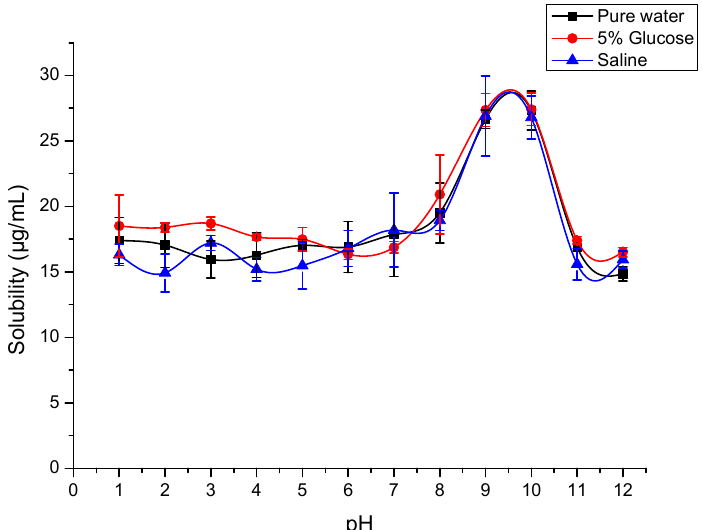
Figure 7. Solubility of SG-PTX at different pH conditions in three common media. All values are expressed as mean ± SD (n = 4).